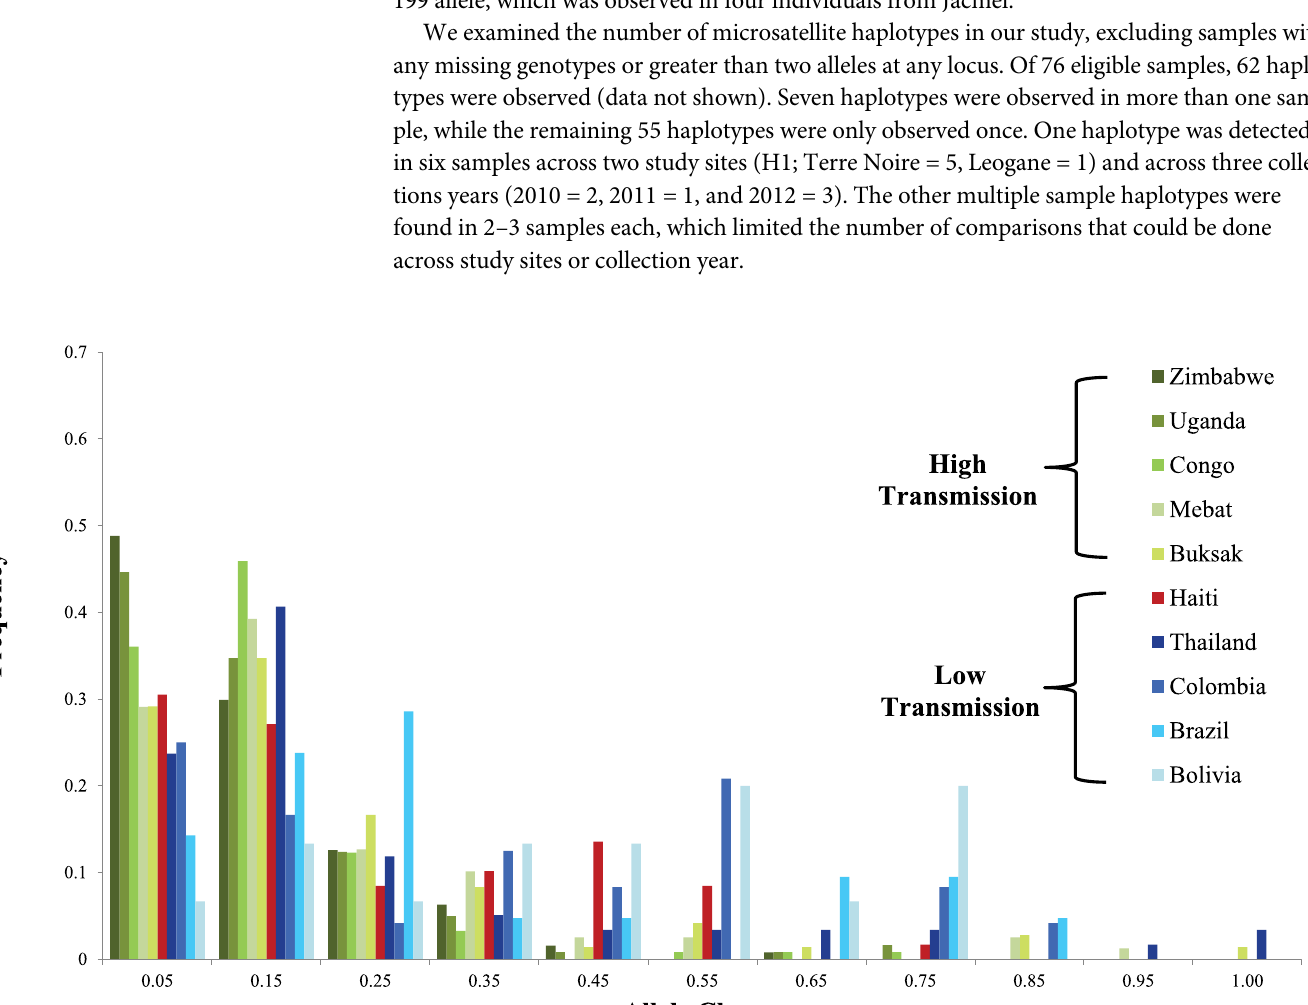
Fig 2. Allele frequency distribution in Haiti compared to high and low malaria transmission countries. Non-Haitian data taken from Anderson et al. [20]. Mebat and Buksak are sites within Papua New Guinea.